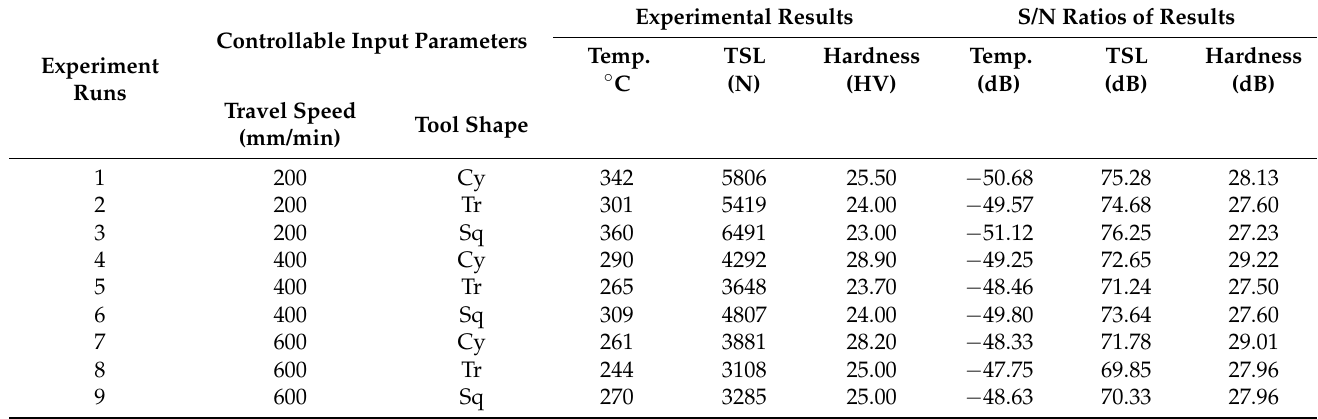
Table 4. Experimental plan, experimental results, and their calculated S/N ratios.